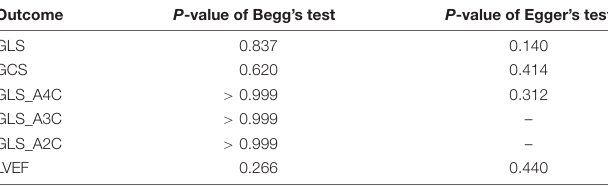
TABLE 3 | Assessment of publication bias.